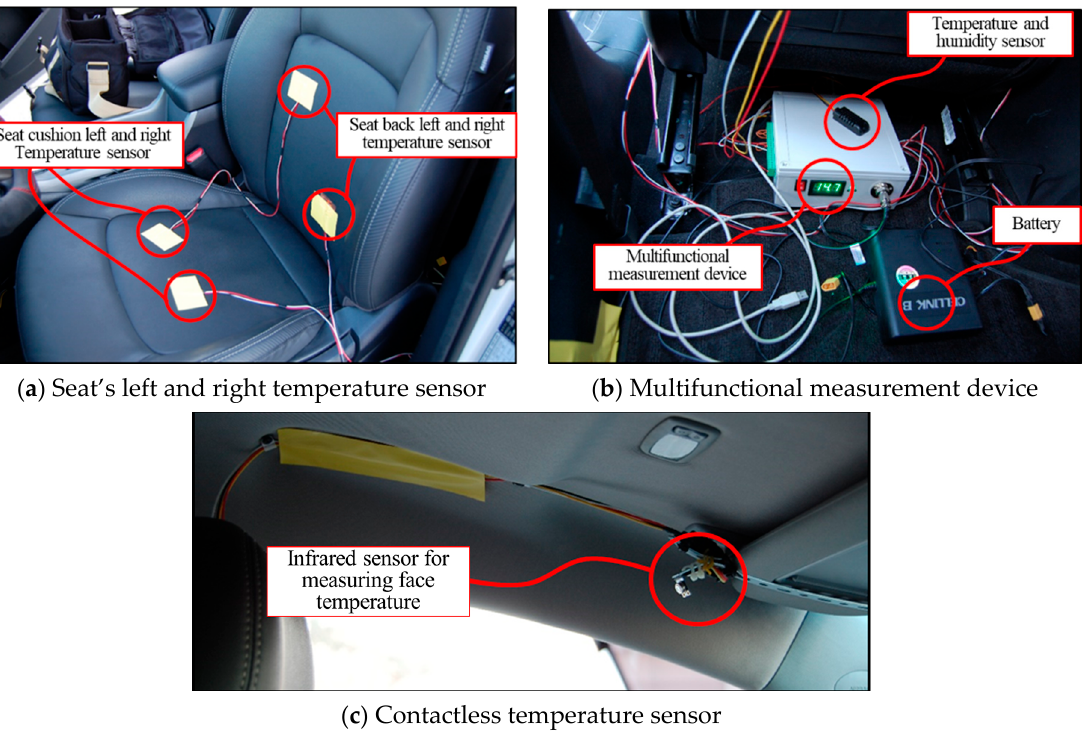
Figure 2. MFMSD installation in actual vehicles: ( a ) seat’s left and right temperature sensor; ( b ) multifunctional measurement device; and ( c ) infrared sensor for measuring face-skin temperature.